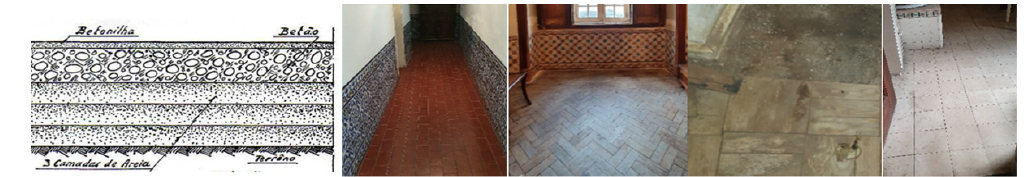
Figure 25. Composition of the ground floor, covered with wooden elements and ceramic tiles. The structure and flooring elements of the upper levels and attic are made of wood.